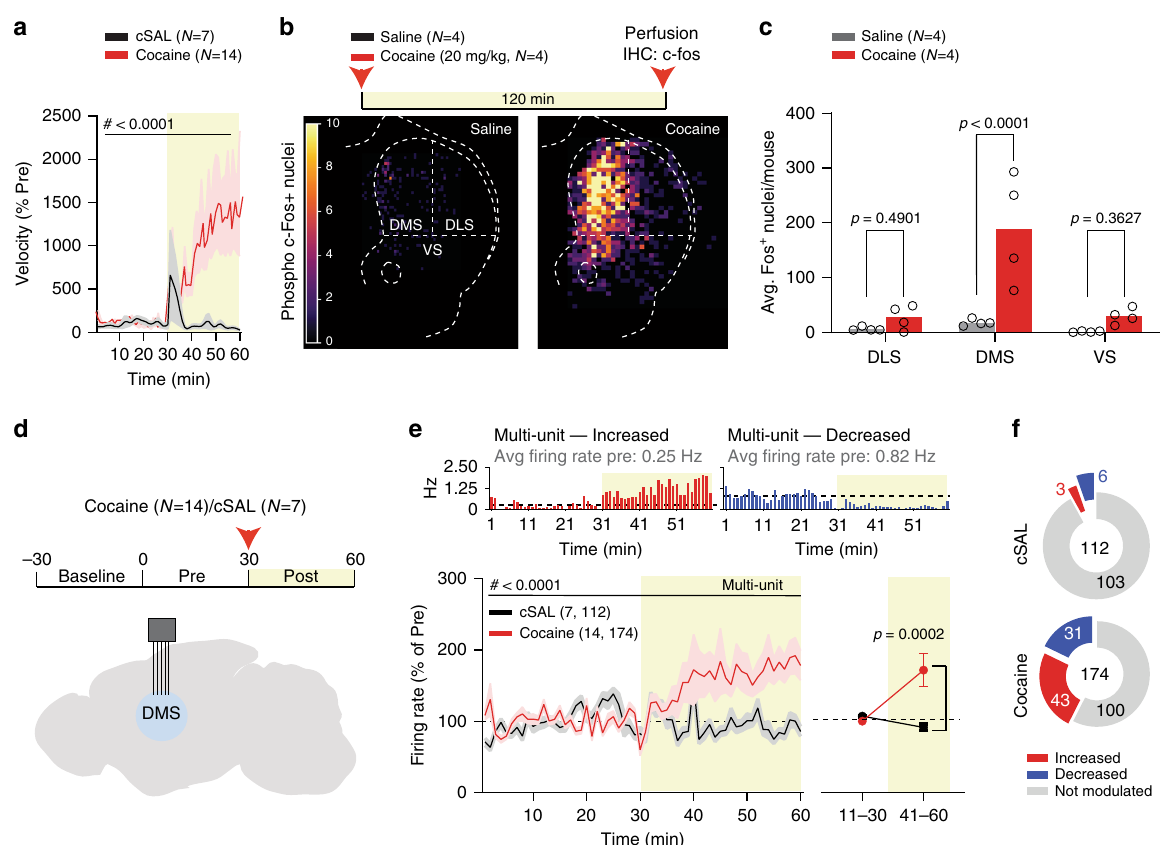
Fig. 1 Cocaine increases neuronal activity in dorsomedial striatum. a Norm. velocity for saline (cSAL) and cocaine (RM two-way ANOVA; time main effect: F (59,1121) = 2.765, p < 0.0001; drug main effect: F (1,19) = 3.829, p = 0.0652; time Χ drug interaction: F (59,1121) = 3.044, p < 0.0001). b Experimental paradigm and heat-map of c-fos expression after i.p. saline or cocaine injections. c Averaged per-mouse phospho-c-fos positive nuclei in dorsolateral (DLS), dorsomedial (DMS) and ventral striatum (VS; RM two-way ANOVA; region main effect: F (2,12) = 13.84, p = 0.0008; drug main effect: F (1,6) = 13.18, p = 0.0110; region Χ drug interaction: F = 9.789, p = 0.0030; followed by between-subject post-hoc False Discovery Rate method of Benjamini, (2,12) Krieger and Yekuteli test for saline vs cocaine; DLS t (18) = 0.7046; DMS t (18) = 5.712; VS t (18) = 0.9339). d Schematics of brain implants and experimental time-course. e Time-course of normalized multi-unit activity (RM two-way ANOVA; time main effect: F (3.063,869.8) = 3.118, p = 0.0246; drug main effect: F = 6.076, p = 0.0143, time Χ drug interaction: F = 4.180, p < 0.0001) and binned analysis of normalized multi-unit activity (RM two-way (1,284) (59,16756) ANOVA; time main effect: F (1,284) = 3.732, p = 0.0544; drug main effect: F (1,284) = 6.511, p = 0.0112; time Χ drug interaction: F (1,284) = 9.185, p = 0.0027, followed by between-subject Bonferroni post hoc test cSAL vs COC; 11 – 30: t (568) = 0.3359, p > 0.9999; 41 – 60: t (568.0) = 3.947). Insets at top: example rate histograms showing multi-units that increased and decreased fi ring after cocaine. f Pie-charts of non-modulated, potentiated or depressed multi-units after saline or cocaine i.p. injections. Data are represented as single points and/or as mean ± SEM (standard error of the mean). N and n indicate number of mice and multi-units,